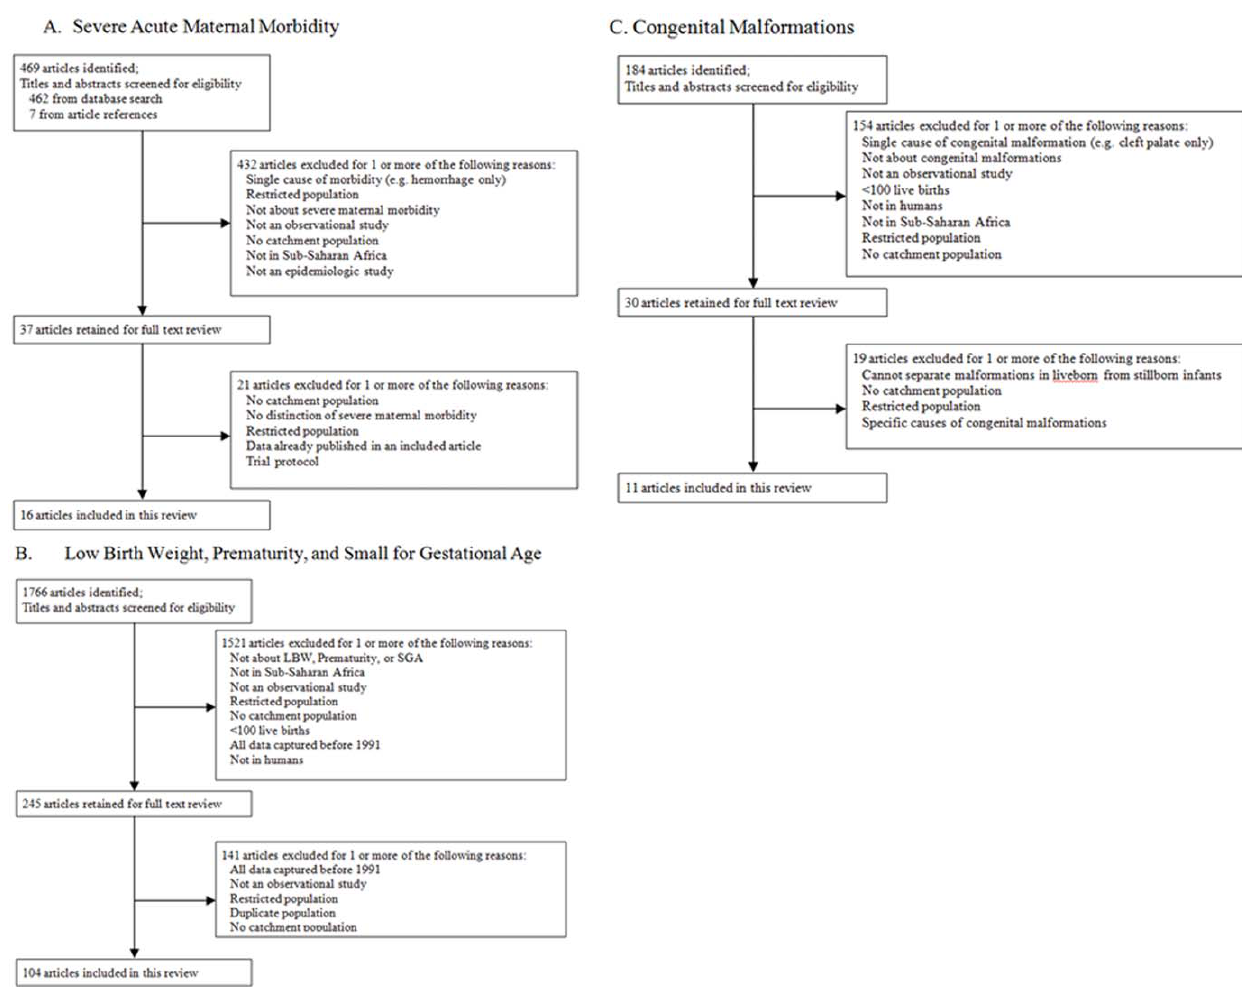
Figure 2. Summary of literature search and study selection. A. Severe Acute Maternal Morbidity. B. Low Birth Weight, Prematurity, and Small for Gestational Age. C. Congenital Malformations.